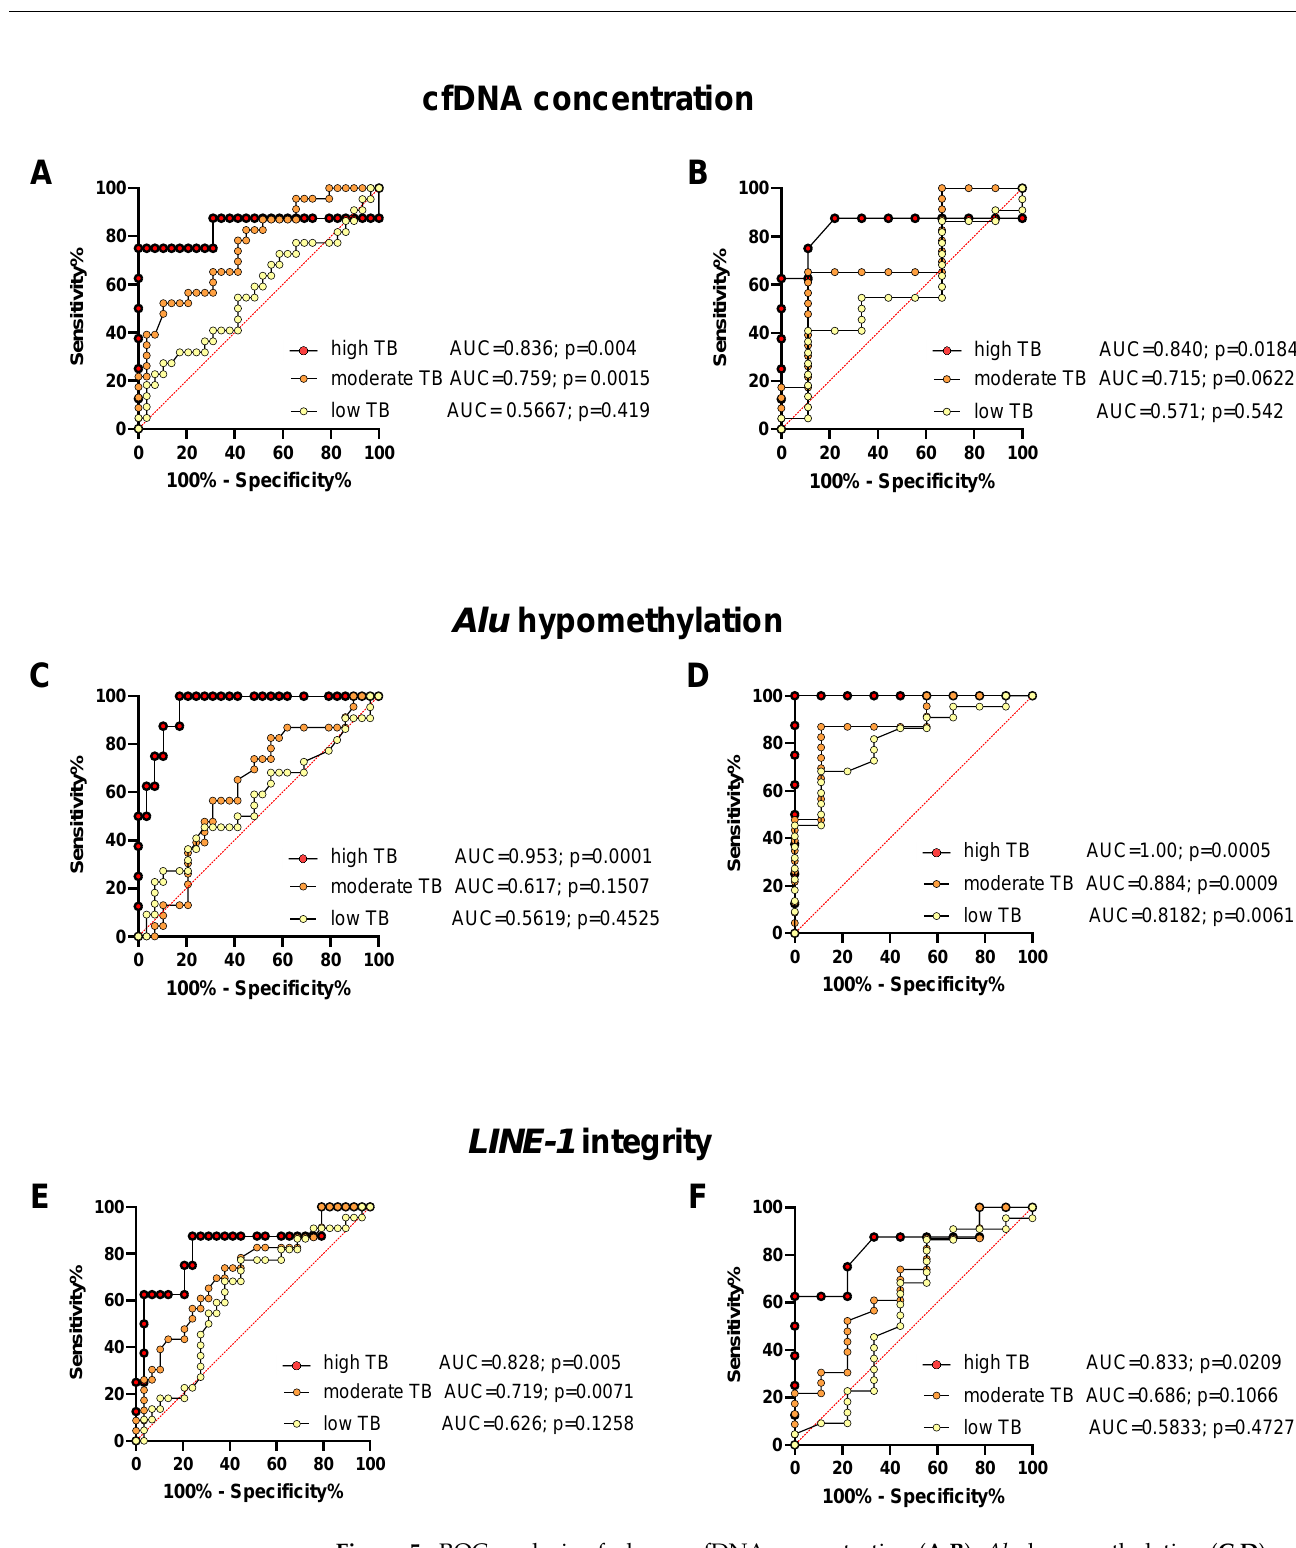
Figure 5. ROC analysis of plasma cfDNA concentration ( A , B ), Alu hypomethylation ( C , D ), and LINE-1 integrity ( E , F ) for distinguishing healthy controls ( A , C , E ), or cured patients ( B , D , F ) from patients with low, moderate, and high tumor burden (TB), along with the area under the curve (AUC), for sensitivities and specificities see Table S2 in the Supplement.